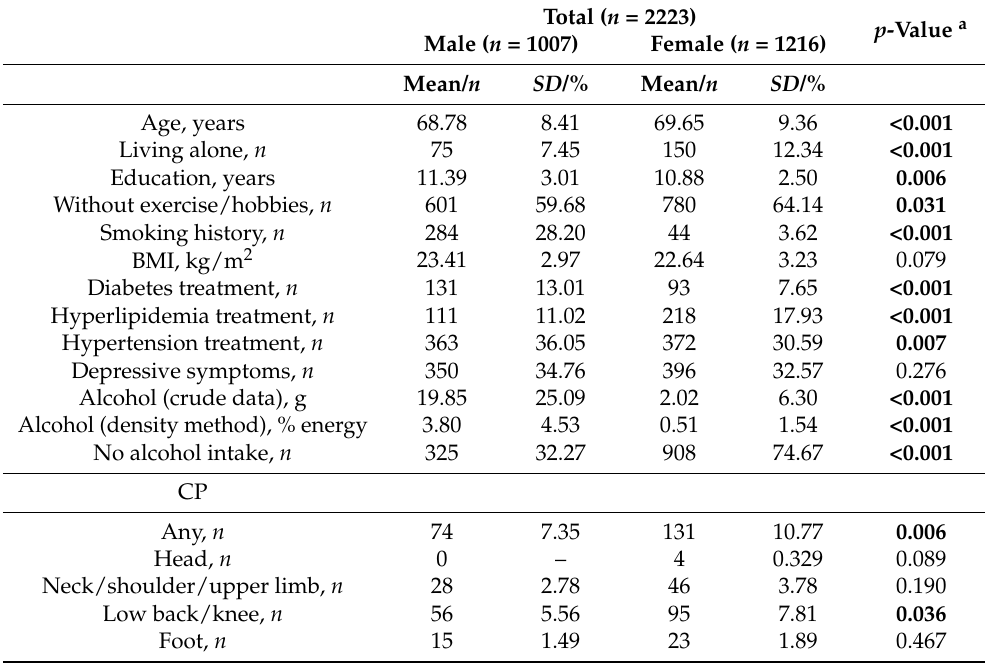
Table 1. Participant characteristics.